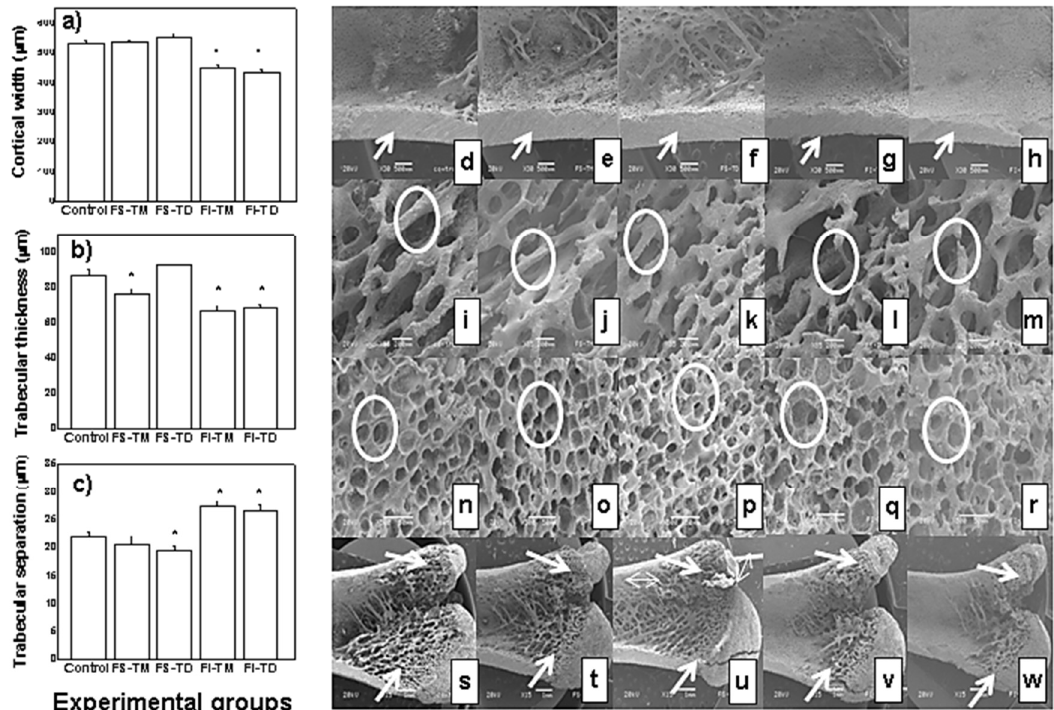
Figure 1. Microstructural parameters of the femurs of male Wistar growing rats fed with the control diet and the soluble and insoluble fiber of O. ficus indica cladodes at early and late maturity stages as the only dietary calcium source. ( a ) Indicates the cortical width of the femoral diaphysis (Ct.Wi); ( b ) displays the trabecular thickness of femoral metaphysis (Tb.Th); ( c ) exhibits trabecular separation of the femoral epiphyseal line growth (Tb.Sp). The values represent the mean ± SD n = 7. * Significantly different from the values of bones from rats fed the control diet ( p ≤ 0.05). Scanning electron microscopy images left to right: Control, FS-TM, FS-TD, FI-TM, and FI-TD groups. The micrographs ( d – h ) show the cortical width of femoral diaphysis (35×). The micrographs ( i – m ) show the trabecular thickness in femoral bones (85×). The micrographs ( n – r ) show details of the trabecular tissue in femoral bones (500×). The micrographs ( s – w ) show the inner part of the longitudinally sectioned femur from the line between condyles towards the diaphysis (15×).